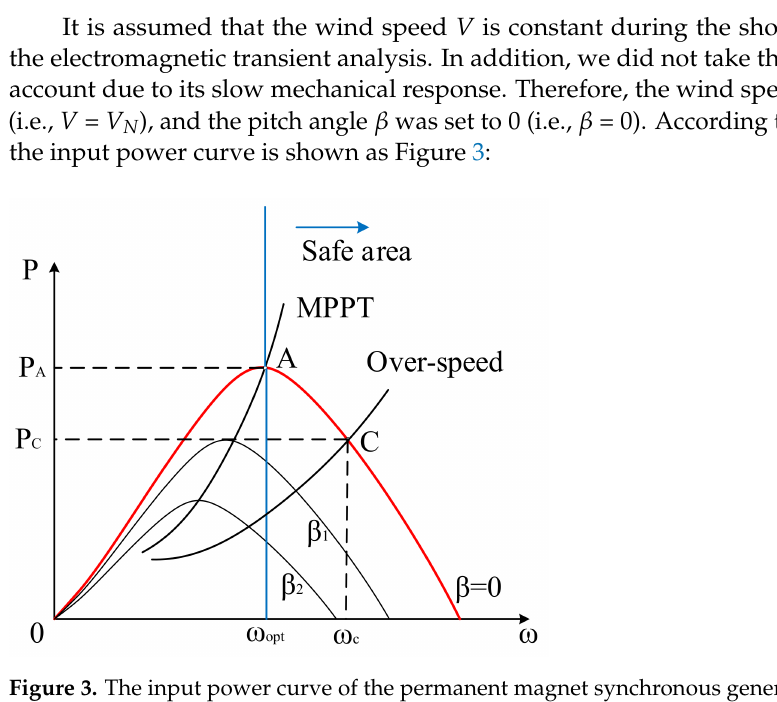
Figure 3. The input power curve of the permanent magnet synchronous generator